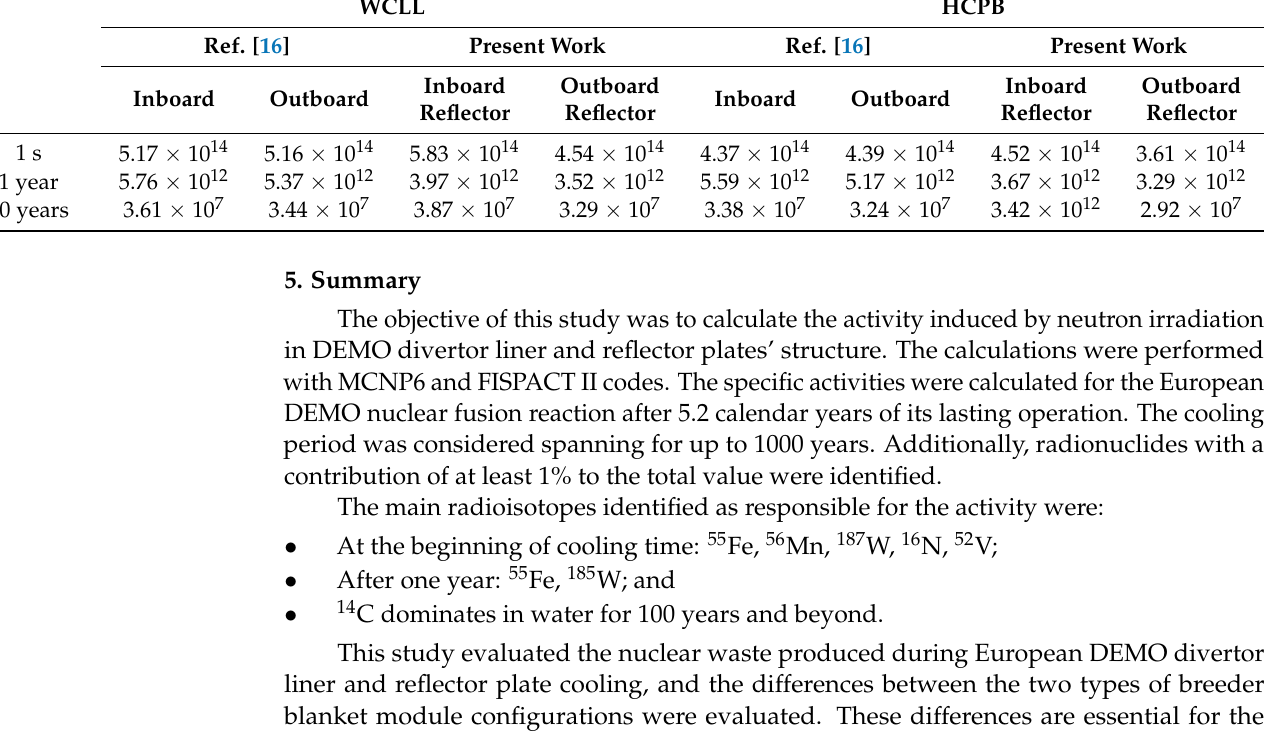
Table 3. Comparison of specific activity with Ref. [16] [Bq/kg].